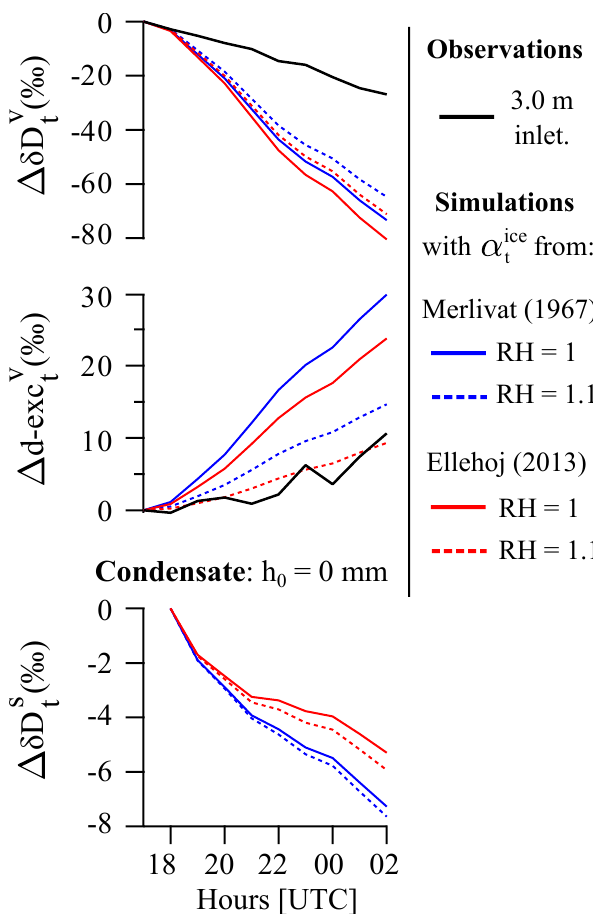
Figure 6. Measured and simulated (box model) deuterium anoma- lies of the vapor and simulated deuterium anomaly of the con- densate ( h 0 = 0mm) during the cooling phase, from 17:00 to 02:00UTC. Observations come from the stack of the 18 diurnal cy- cles. Equivalent fractionation coefficients have been calculated from Jouzel and Merlivat (1984) for RH =